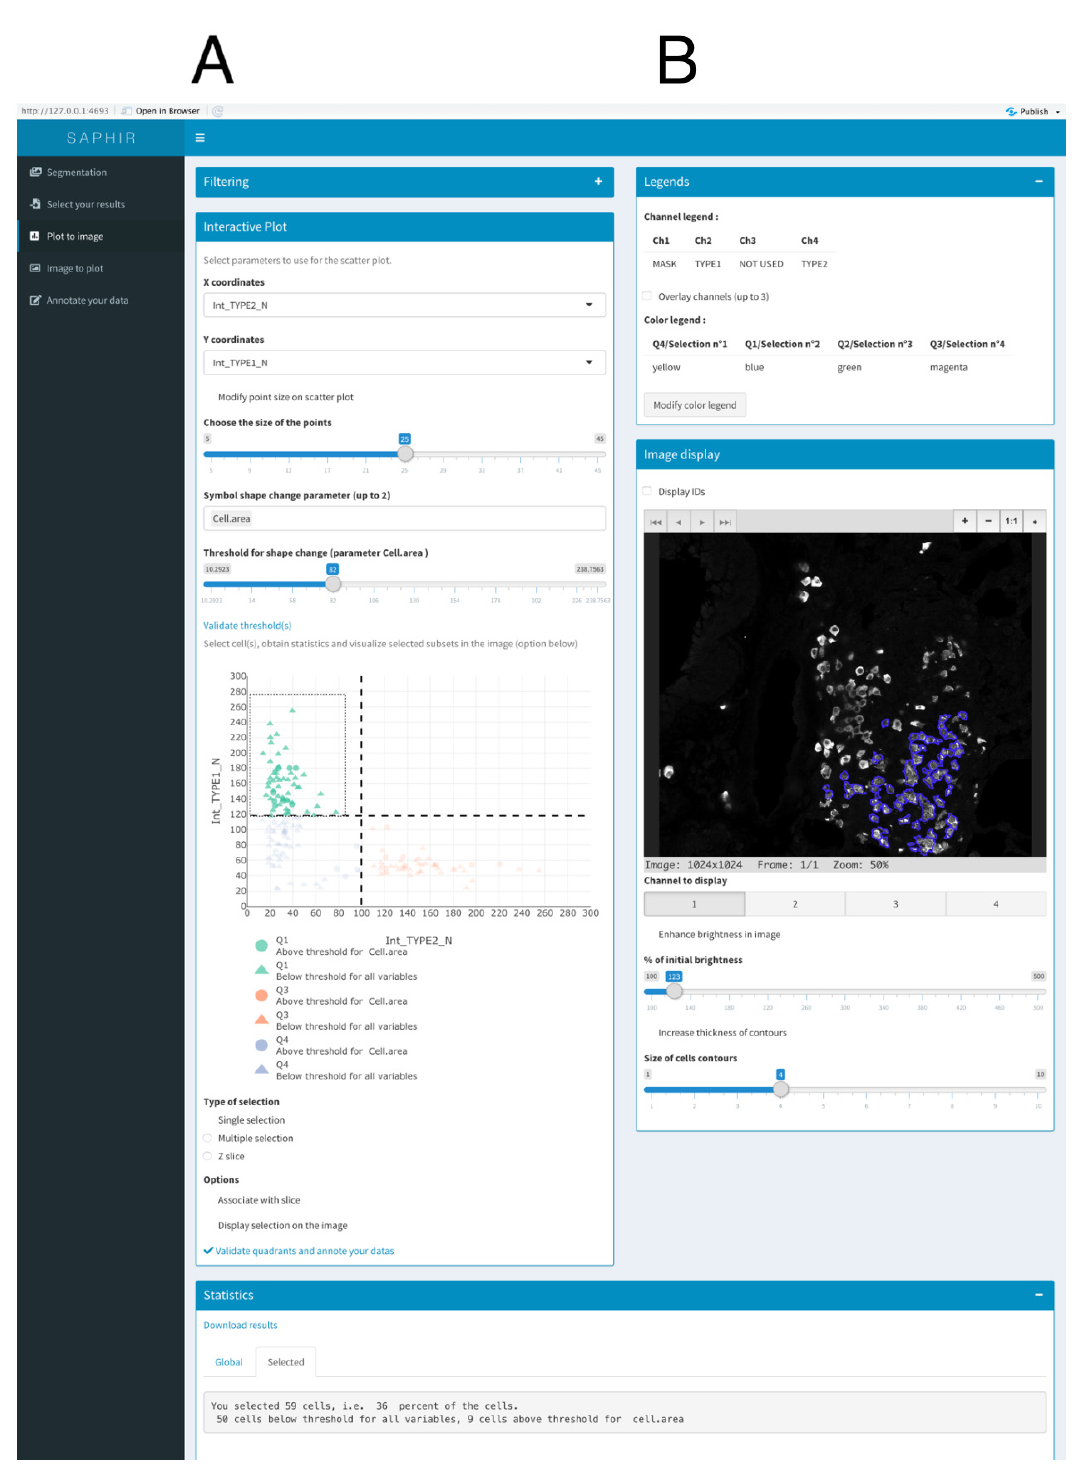
Figure 3. Menu “Plot to Image” of SAPHIR application. ( A ) Scatterplot of two channel intensity parameters used to gate COI. User can add a third parameter that is displayed on the scatterplot through a change of symbol shape for COI beyond a threshold defined by the user. ( B ) Visualization of selected cells in the image. Some of the available options are shown (displayed channel(s), channel overlay, cell identity number,